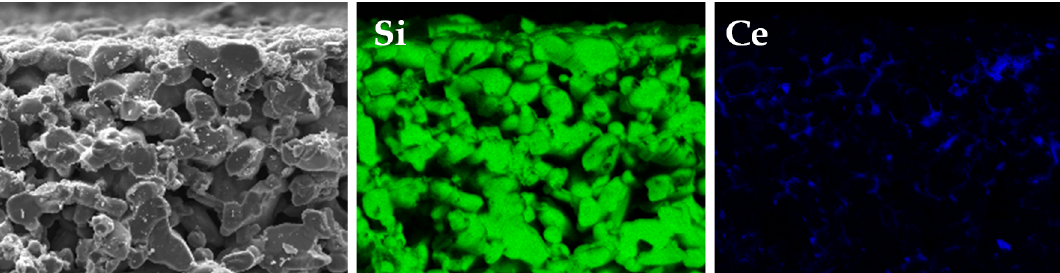
Figure 5. Cross section of a channel of a ceria-coated DPF: SEM image and EDX maps of the corresponding area for silicon (Si) and cerium (Ce). Adapted from [15].